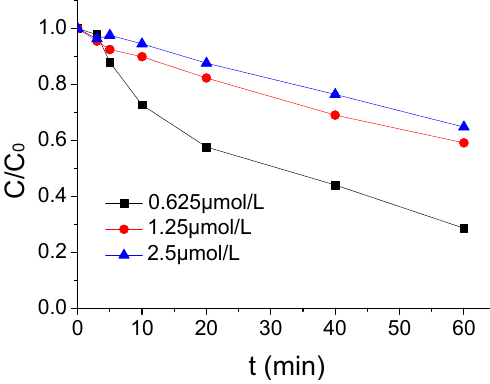
Figure 5. The ATZ removal rates under different ATZ density C 0.